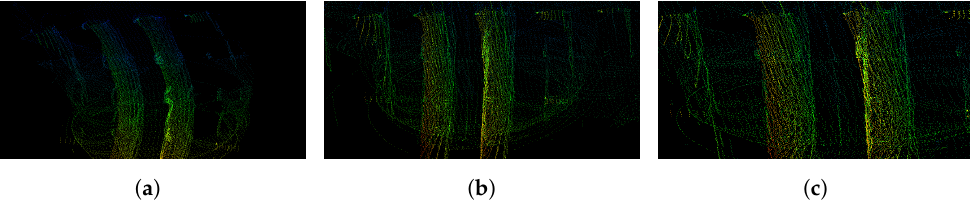
Figure 6. Maps, from the same viewpoint, generated with varying maximum LiDAR ranges, L max .